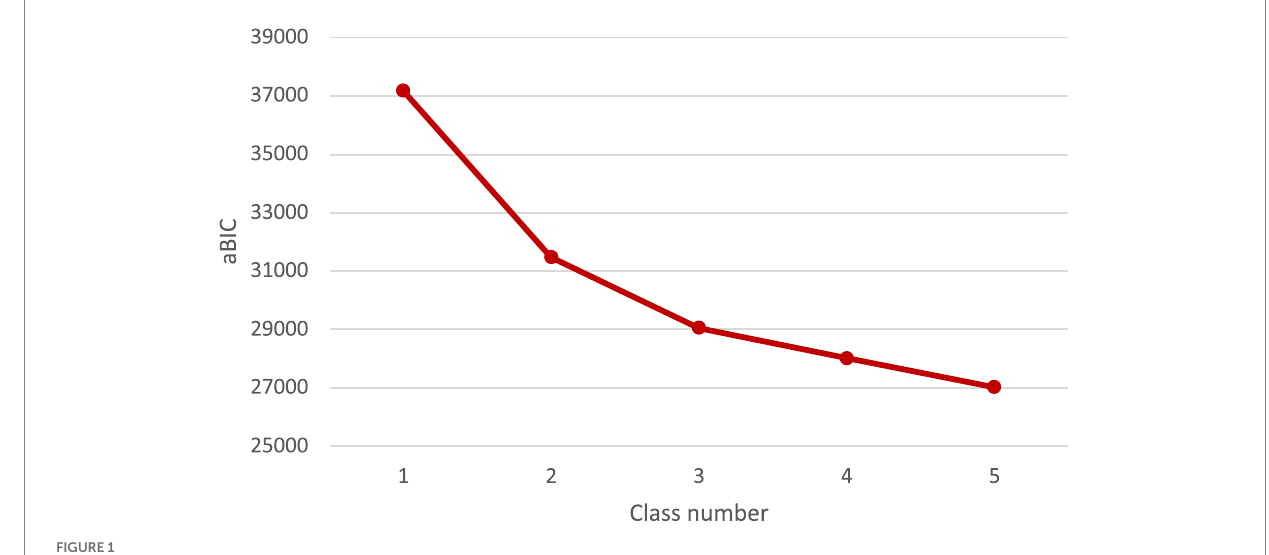
FIGURE 1 Scree plot of change trend of adjusted Bayesian Information Criterion (aBIC).